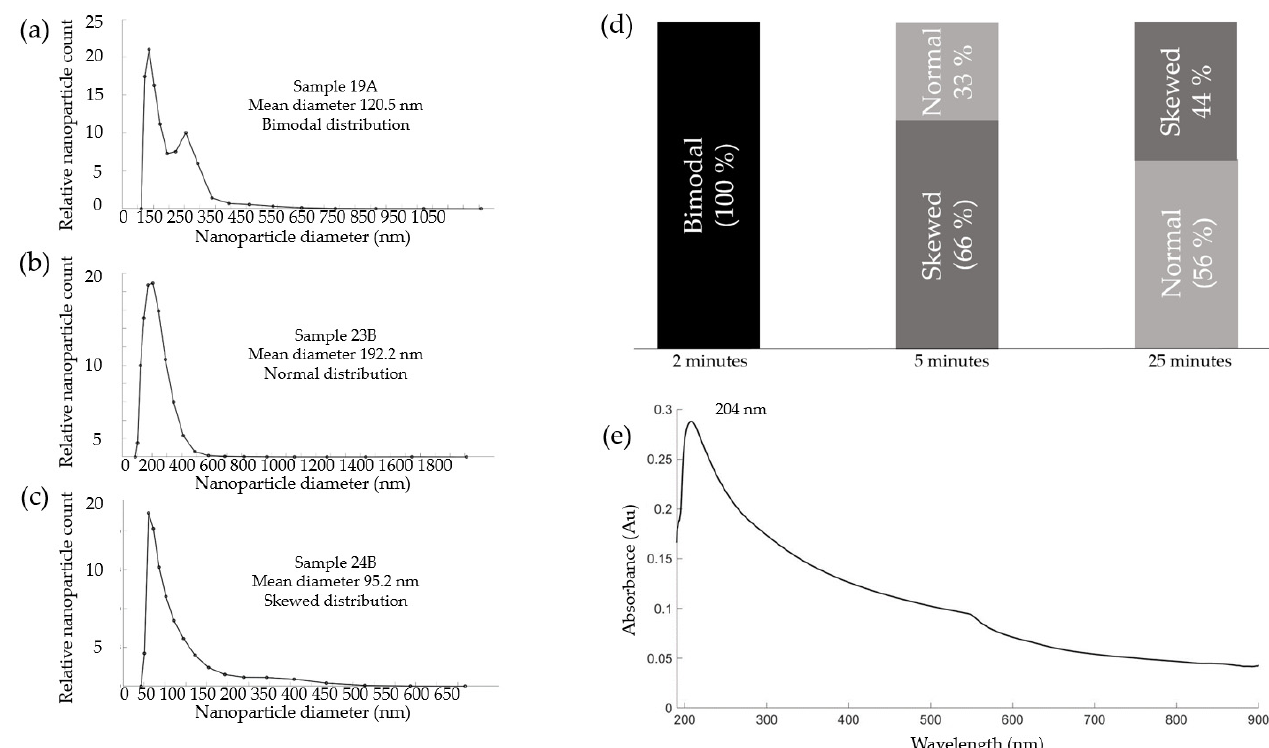
Figure 4. ( a ) Sample with bimodal nanoparticle size distribution after 2 min; ( b ) sample with normal nanoparticle size distribution after 5 min; ( c ) sample with positively skewed nanoparticle size distribution after 25 min; ( d ) effect of ablation time on nanoparticle size distribution. All samples are bimodal at 2 min, mostly skewed at 5 minutes and mostly normally distributed at 25 min; ( e ) typical UV–Vis curve for a magnesium colloid. A distinct peak is observed at a wavelength of about 204 nm.